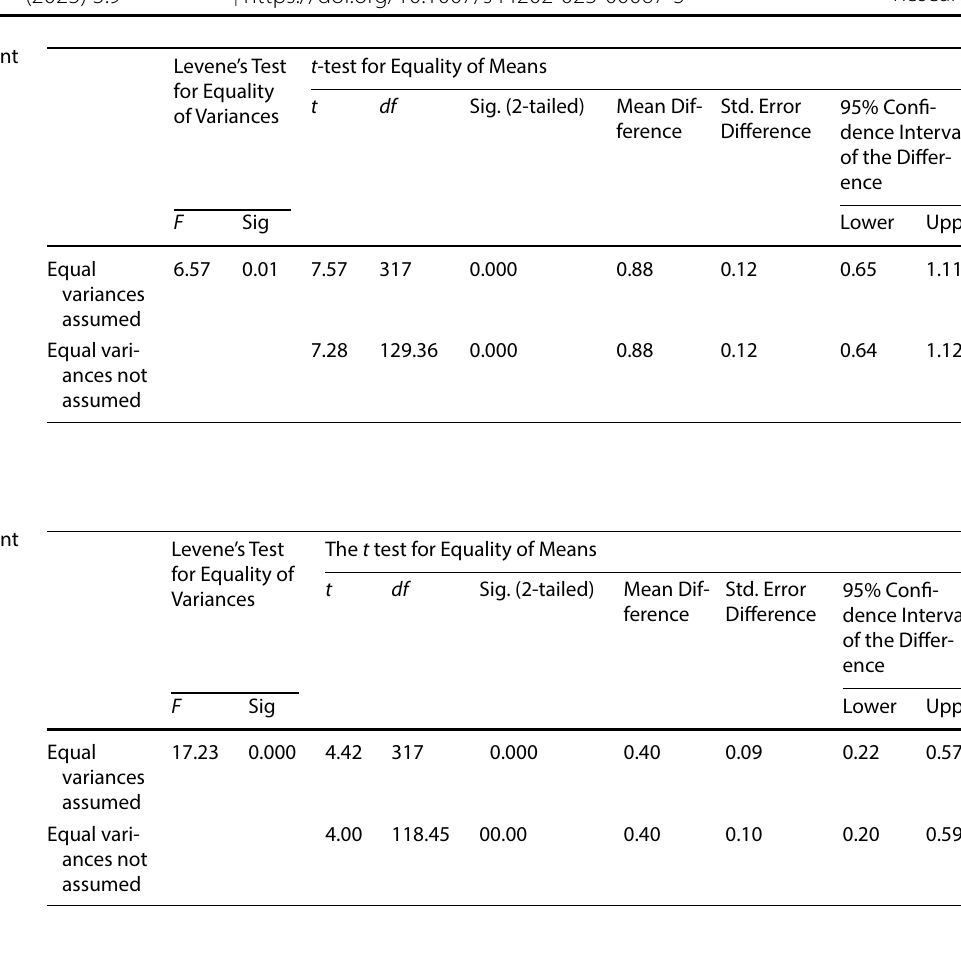
Table 6 t -test for Independent Samples